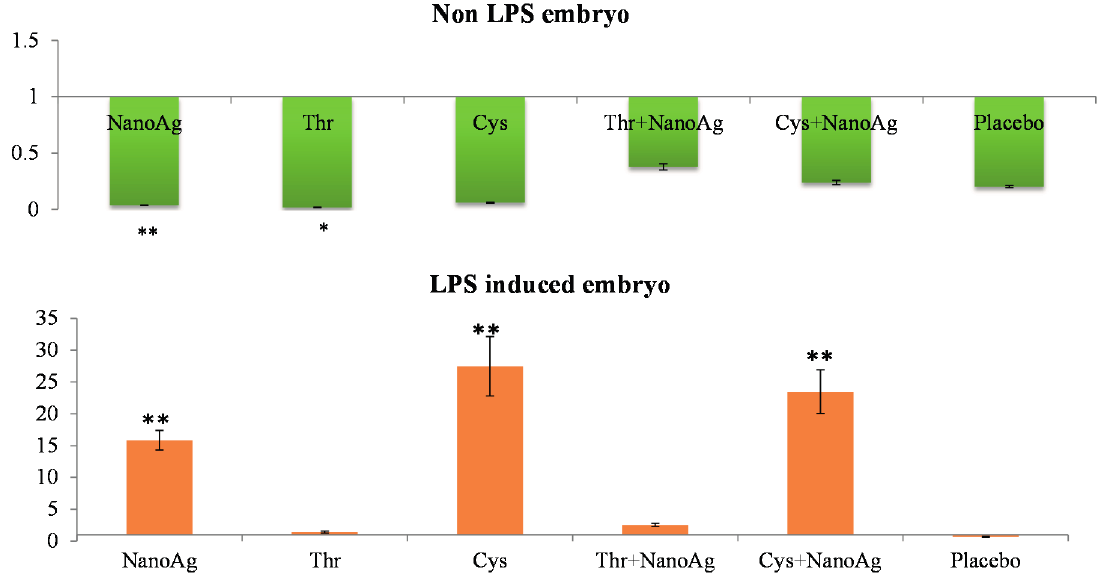
Figure 2. Relative fold expression level of interleukin-6 ( IL-6 ) gene in hepatic tissues of normal (non-LPS) and LPS induced in ovo NanoAg and/or amino acid injected embryos. Expression of uninjected control embryo is taken as 1.0. * and ** indicates significant expression at the level of 95% ( p < 0.05) and 99% ( p < 0.01),